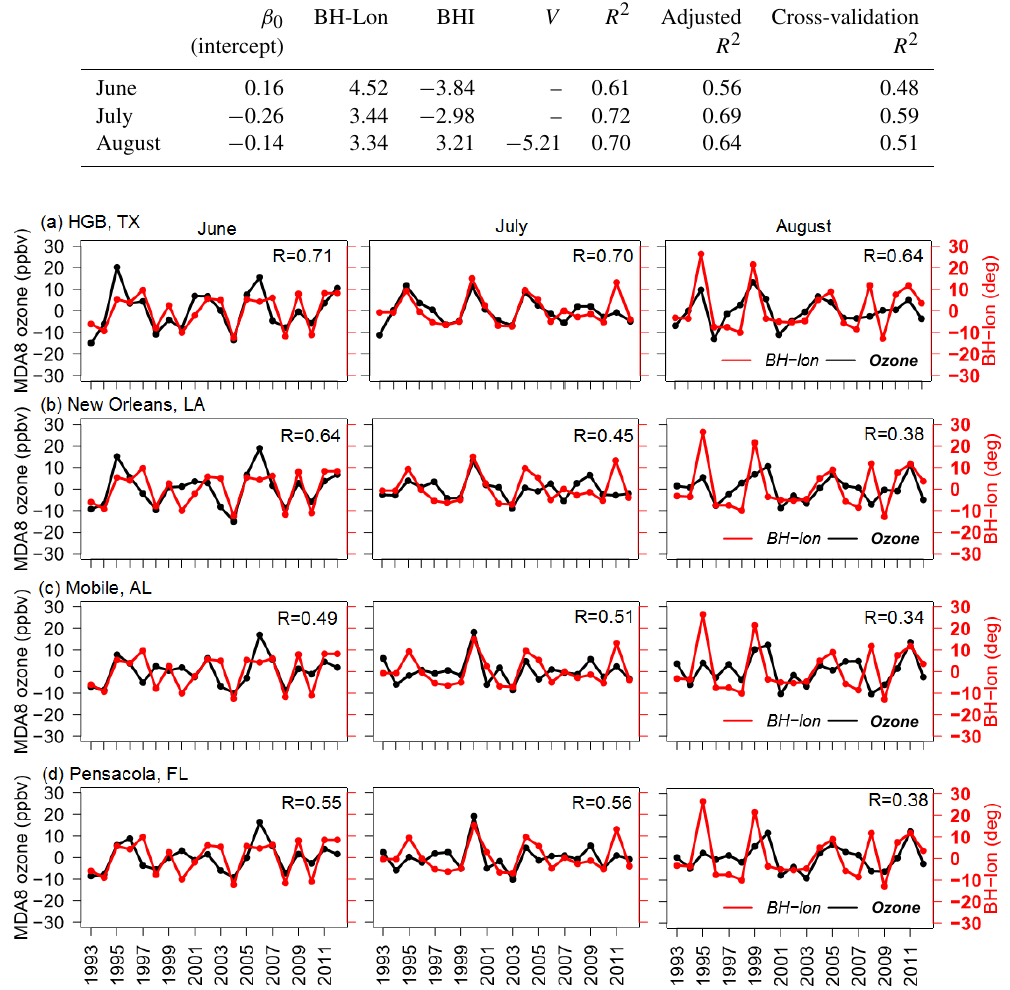
Figure 6. The time series of detrended BH-Lon (red line) and MDA8 ozone (black line) during June, July, and August over the HGB region, TX (a) , New Orleans, LA (b) , Mobile, AL (c) , and Pensacola, FL (d) . The correlation coefficients between BH-Lon and ozone are shown in each